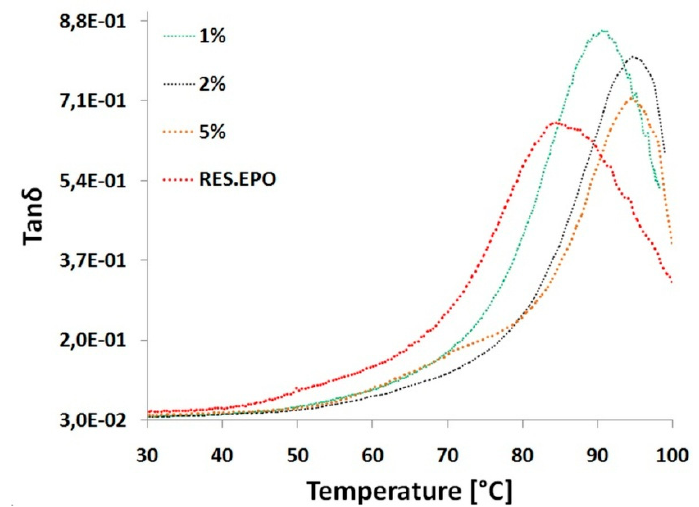
Figure 7. Comparison between the experimental values of Tan δ (calculated as storage and loss modulus ratio) for different volumetric percentage of filler content in the epoxy resin.